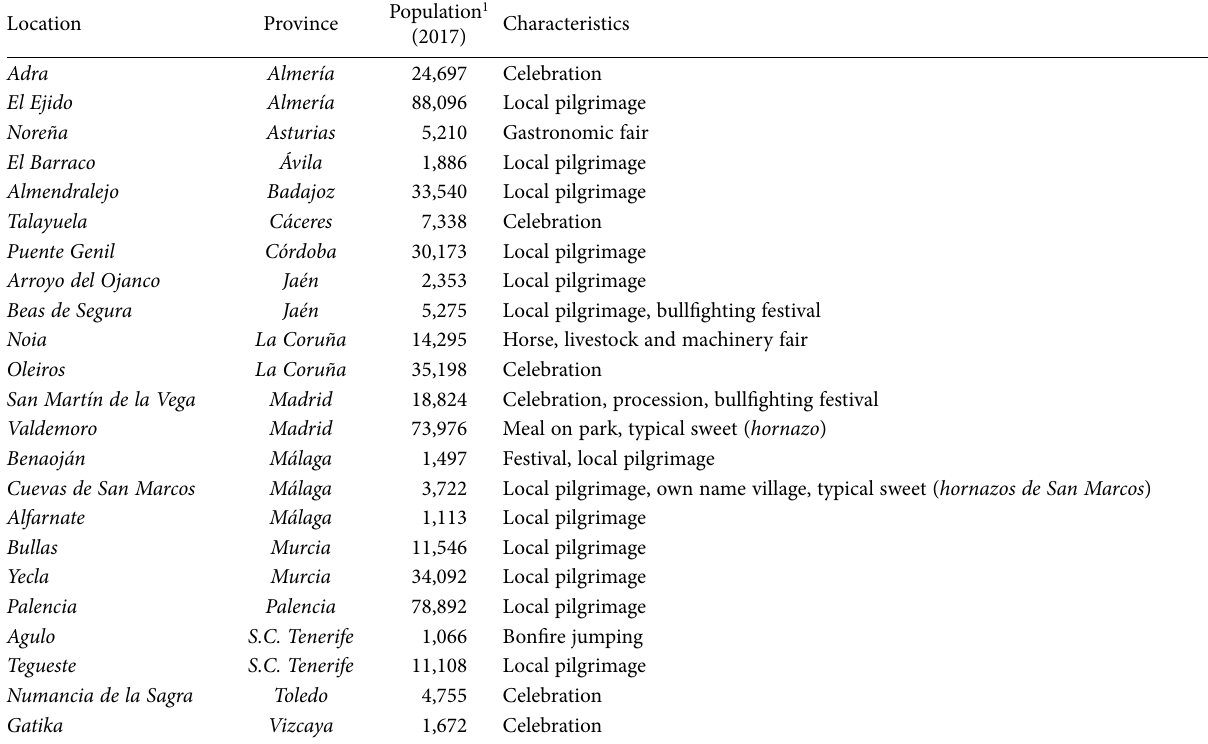
Table 1. Selected locations in Spain where Saint Mark’s day is a popular